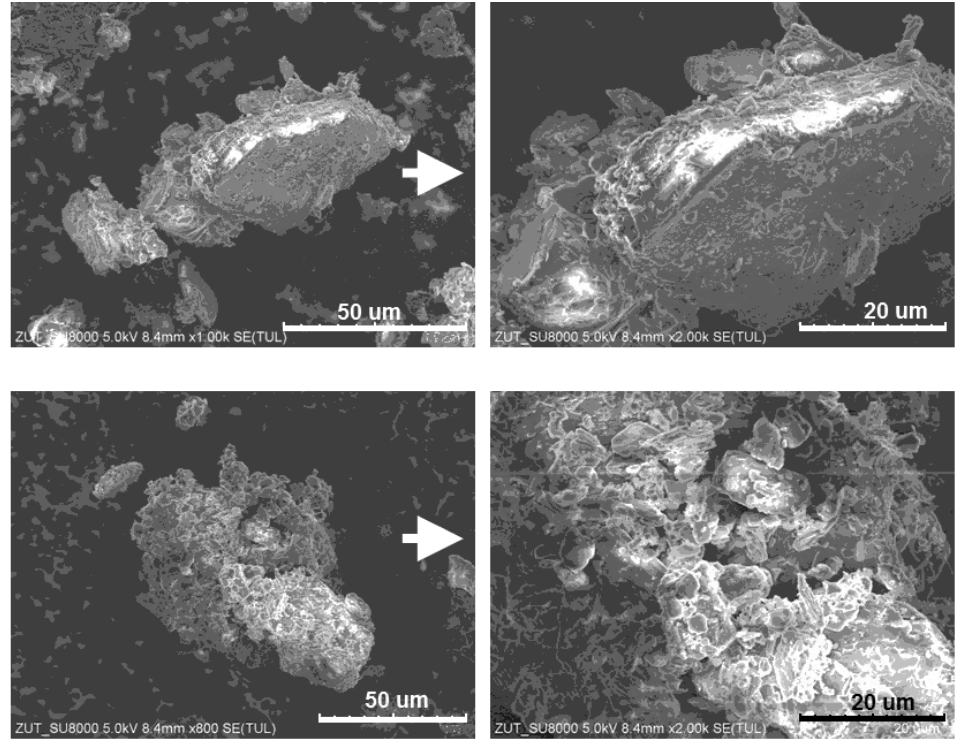
Figure 5. SEM images of the PER-CNTs-3 particles.